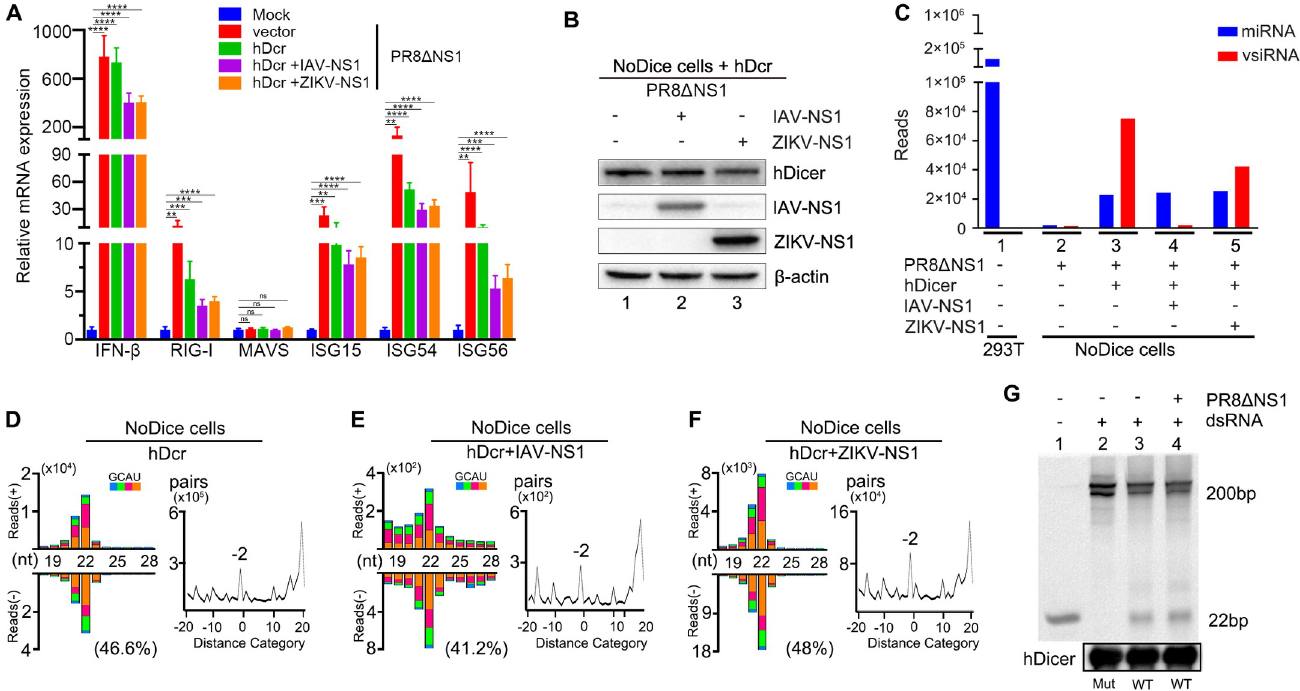
Fig 1. Efficient Dicer processing of IAV derived-dsRNA in human 293T cells active in type I IFN response. A. Induction of type I IFN response in NoDice cells. NoDice cells were mock-inoculated or infected with PR8/delNS1 at 6 hours post-transfection with the plasmid vector, an hDcr-expressing plasmid alone or together another plasmid to express IAV-NS1 or ZIKV-NS1. The accumulation levels of IFN- β , RIG-I, MAVS, ISG15, ISG54, and ISG56 mRNAs were determined by RT-qPCR at 24 hours post-infection. Each experiment was repeated at least three times independently and error bars indicate the standard deviation. The mRNA level of mock-inoculated cells without plasmid transfection was set as 1. �� indicates p < 0.01, ��� indicates p < 0.001, ���� indicates p < 0.0001 (Student’s t- test). ns indicates no significance. B. Western blotting detection of the ectopically expressed human Dicer and/or IAV-NS1 /hDcr+ZIKV-NS1 as described in (A). Endogenous β -actin was detected as a loading control. C. Relative abundance of cellular miRNAs and IAV-derived 21- to 23-nt small RNAs per million total 18- to 28-nt reads in the individual small RNA libraries prepared from the NoDice cells at 24 hours post-infection as described in (A). D-F. Size distribution of IAV- derived 18- to 28-nt small RNAs (left) and duplex pattern of 22-nt IAV vsiRNAs (right) in the 3 libraries (no. 3, 4 and 5) presented in (C) from PR8/ delNS1-infected NoDice cells ectopically expressing hDcr alone (D) or with IAV-NS1 (E) or ZIKV-NS1 (F). Data information: Reads were shown as per million total 18- to 28-nt reads. The 5’ terminal nucleotide of 18- to 28-nt viral small RNAs was indicated by color and 1U % of 21- to 23-nt vsiRNA given in parenthesis. The “-2” peak corresponded to the pair of canonical 22-nt vsiRNAs with a 20-nt duplex region plus 2-nt 3’ overhangs, calculated by an algorithm described previously counting pairs of complementary 22-nt vsiRNAs in each distance category (in nucleotides) between 5’ and 3’ ends of each pair. Length (nt) indicates x- axis for size distribution. Distance category indicates x-axis for duplex pattern. G. In vitro dicing of a synthetic 200 bp dsRNA by FLAG-tagged wild-type (lanes 3 & 4) or mutant (lane 2) human Dicer immune-precipitated from NoDice cells with or without PR8/delNS1. The Dicer substrate and product RNAs were fractionated by 15% PAGE and detected by GelRed staining. Lane 1: 22bp marker. Each experiment was repeated at least three times independently with one represented image